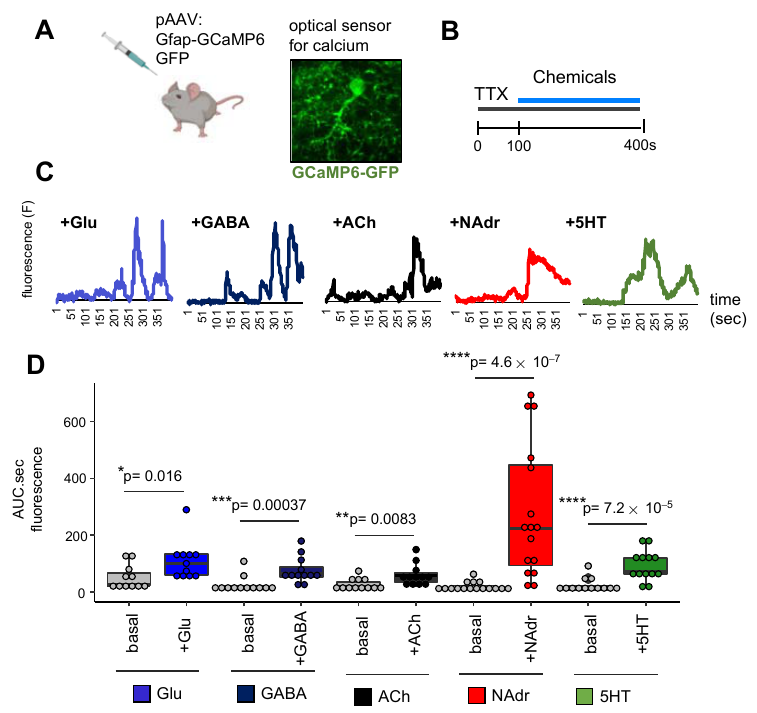
Figure 6. NAdr induces enhanced calcium signaling in vivo compared to Glu, GABA, ACh, and 5HT. ( A , B ) Schematic of calcium imaging experiment showing ( A ) expression of calcium sensor and ( B ) experimental paradigm of neurochemical exposure. ( C ) Representative calcium traces from single astrocytes in response to Glu, GABA, ACh, NAdr, and 5HT. ( D ) Quantification of area under the curve from stimulated astrocytes in comparison to basal ( n = 4–5 mice, 11–16 cells per sample, * p < 0.05, ** p < 0.01, *** p < 0.001, **** p < 0.0001, Wilcoxon test).